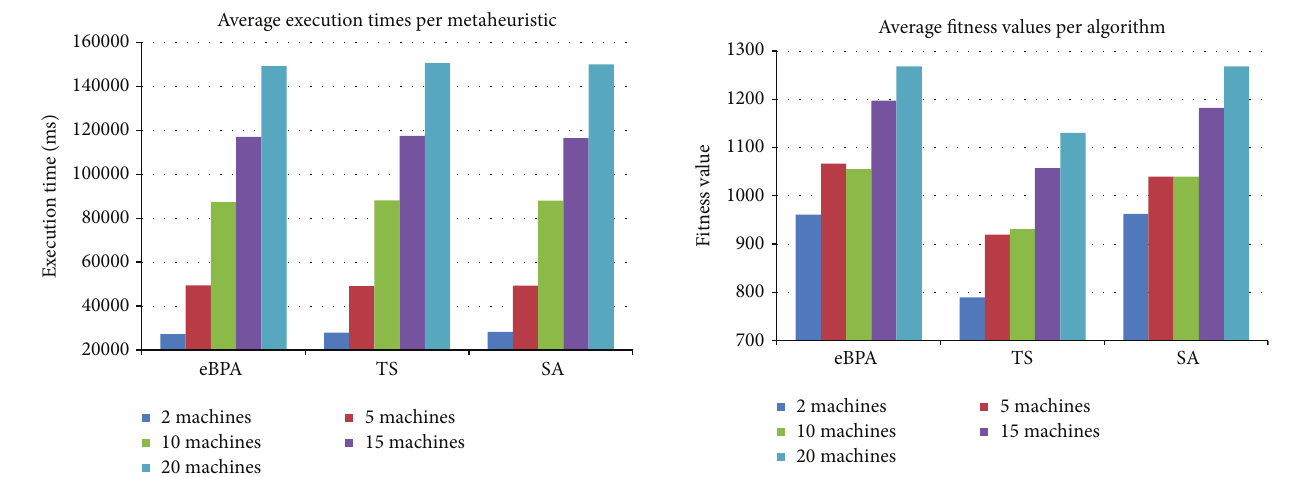
Figure 8: AFV comparisons for the class of 2,500